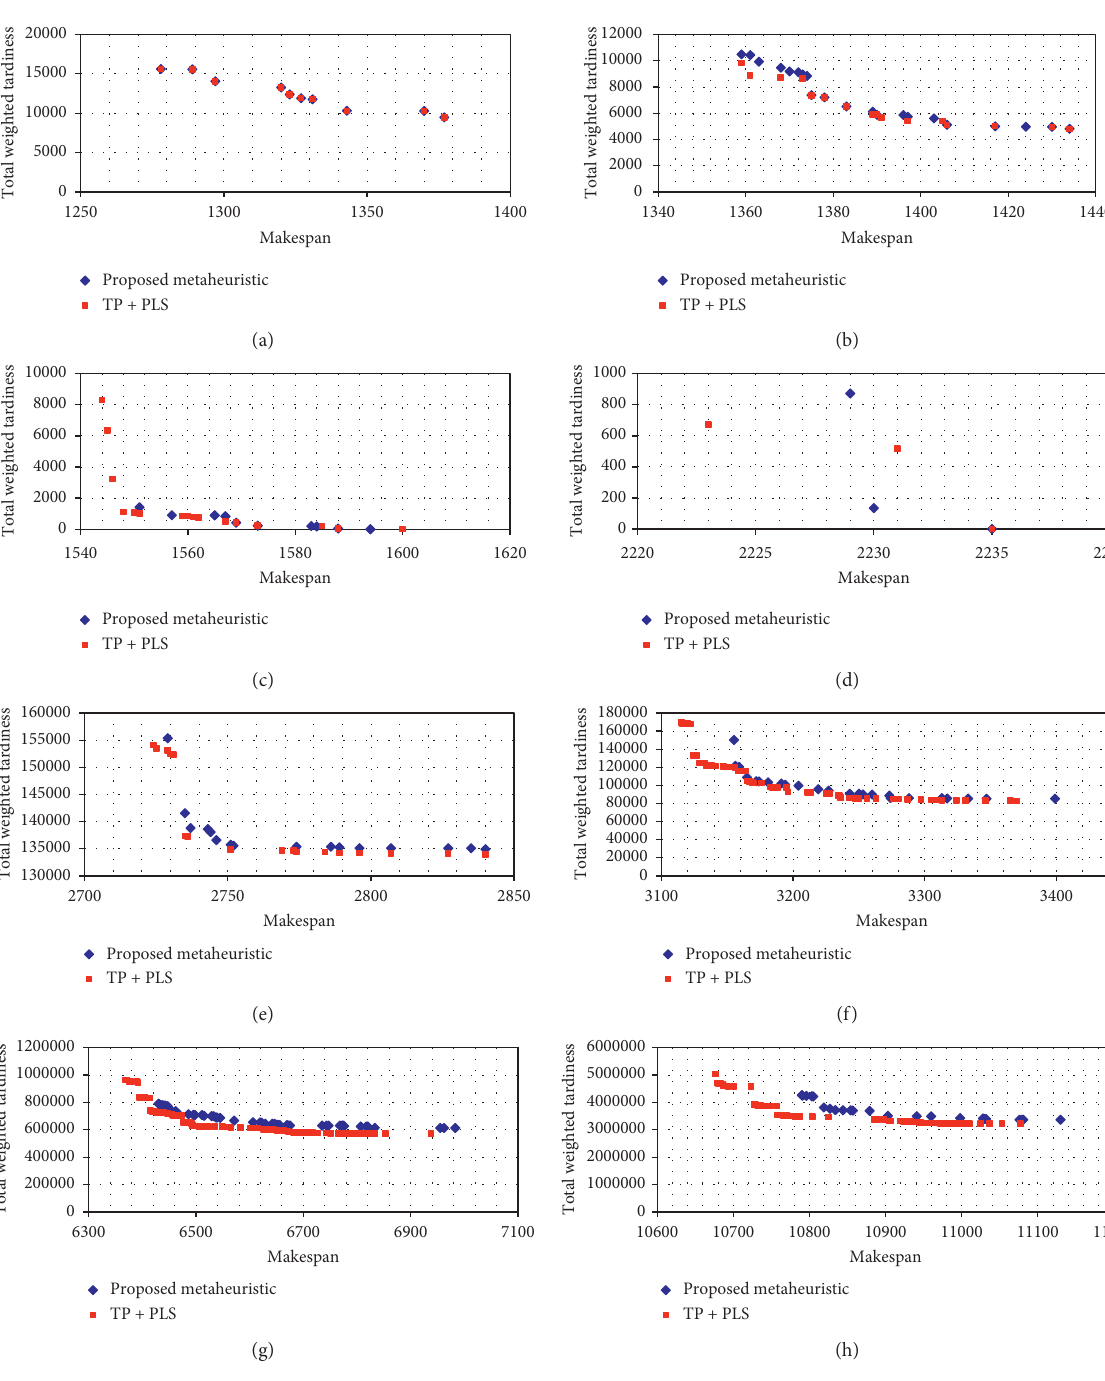
Figure 5: Comparison of Pareto frontiers between the RIPG metaheuristic and the TP+PLS algorithm in a static, biobjective flow shop environment. (a) Problem instance ta001, (b) problem instance ta002, (c) problem instance ta018, (d) problem instance ta024, (e) problem instance ta031, (f) problem instance ta047, (g) problem instance ta084, and (h) problem instance